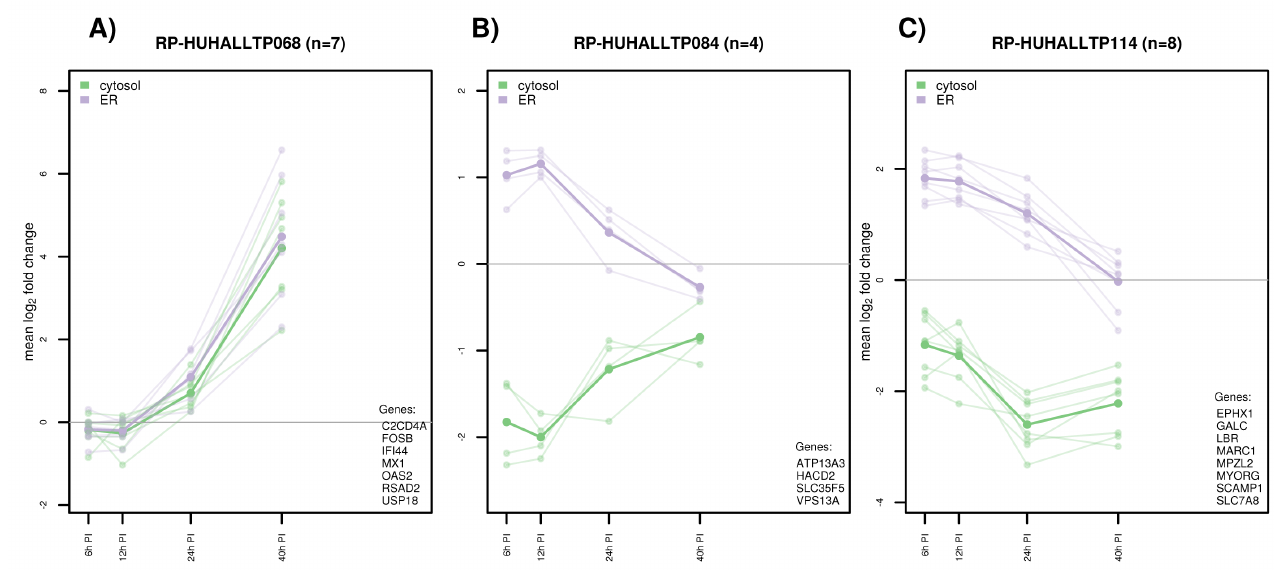
Figure 4. Dengue virus case study: Selection of co-translated gene cluster time trends. Each thin line represents the mean log cluster response for a certain gene. The thick line indicates the mean across genes. Co-translated gene clustered were identified using a bootstrap-based method as implemented in pvclust 21 using the uncentered Pearson correlation distance in combination with complete linkage clustering. ER: endoplasmic